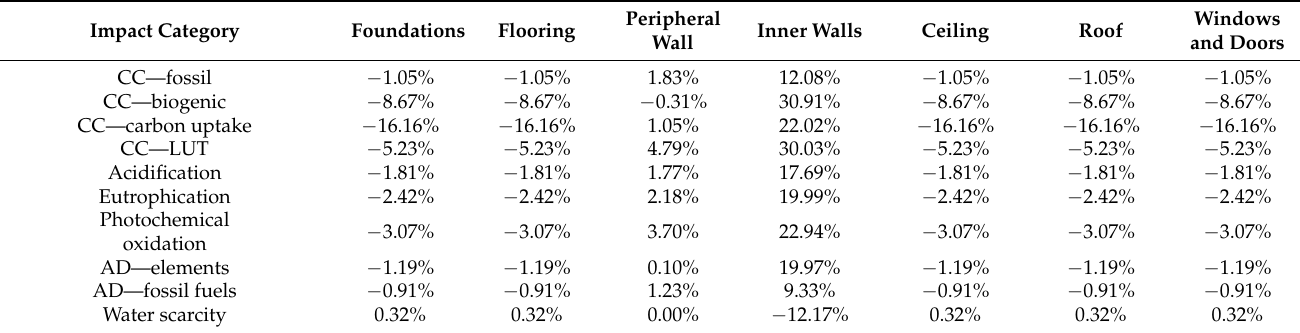
Table 4. MHM panel instead of CLT panel—sensitivity analysis results.